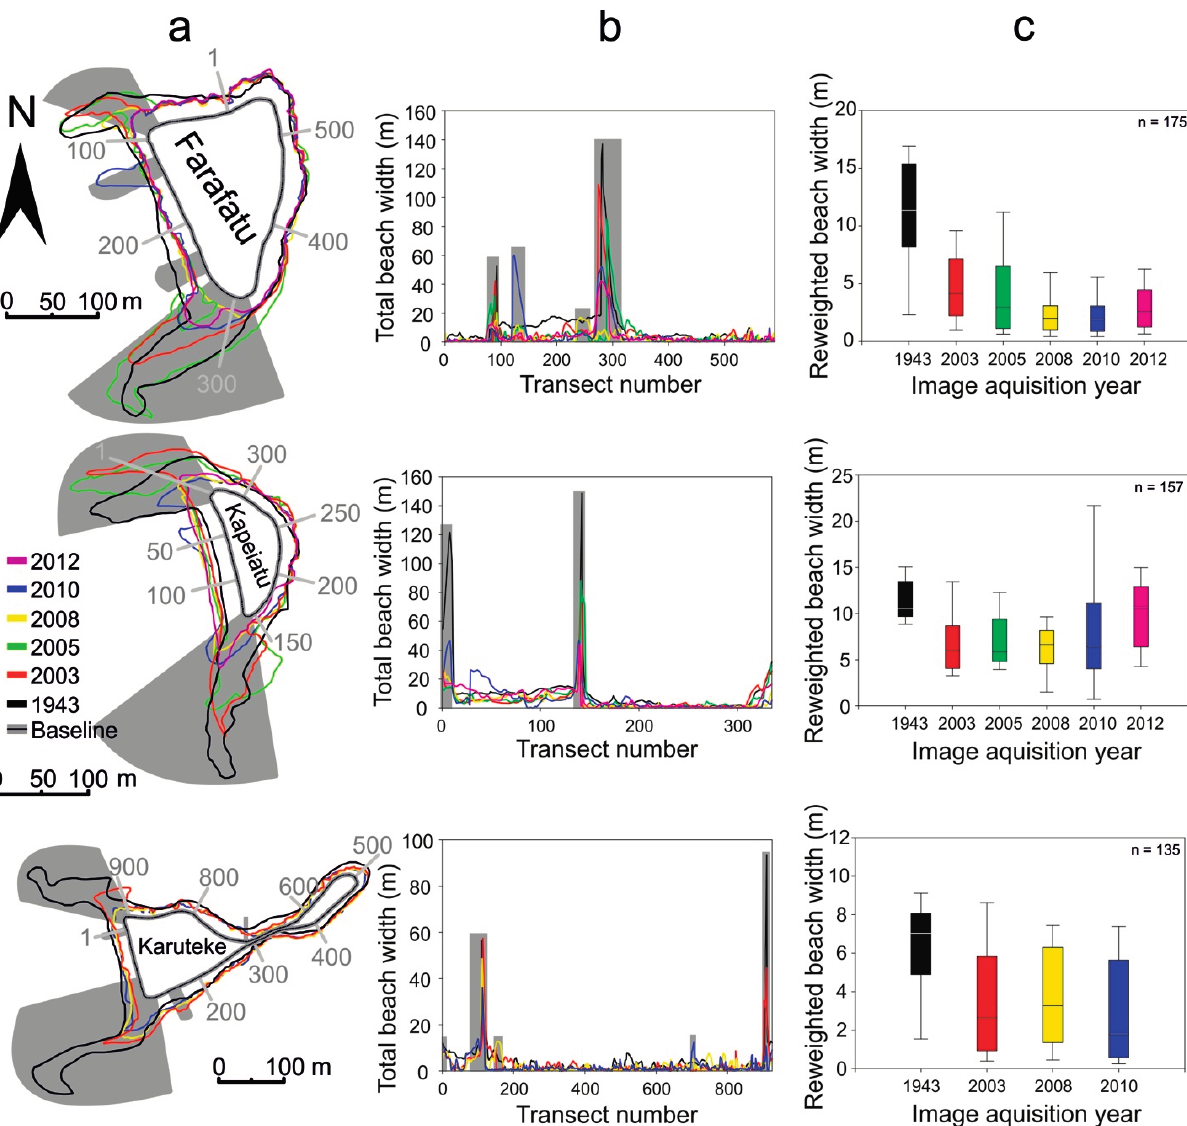
Figure 9. ( a ) Illustration of superposed toe of beach positions for Farafatu, Kapeiatu and Karuteke. Selected transects are marked in light grey to indicate their position on the map (b) Changes in total beach width as a function of Shoreline Change Envelope. Dark grey backgrounds in a and b display the range of transects that comprised extreme high SCE values. (c) Box plots showing the 10th, 25th, 50th, 75th and 90th percentiles of reweighted beach width. n = number of